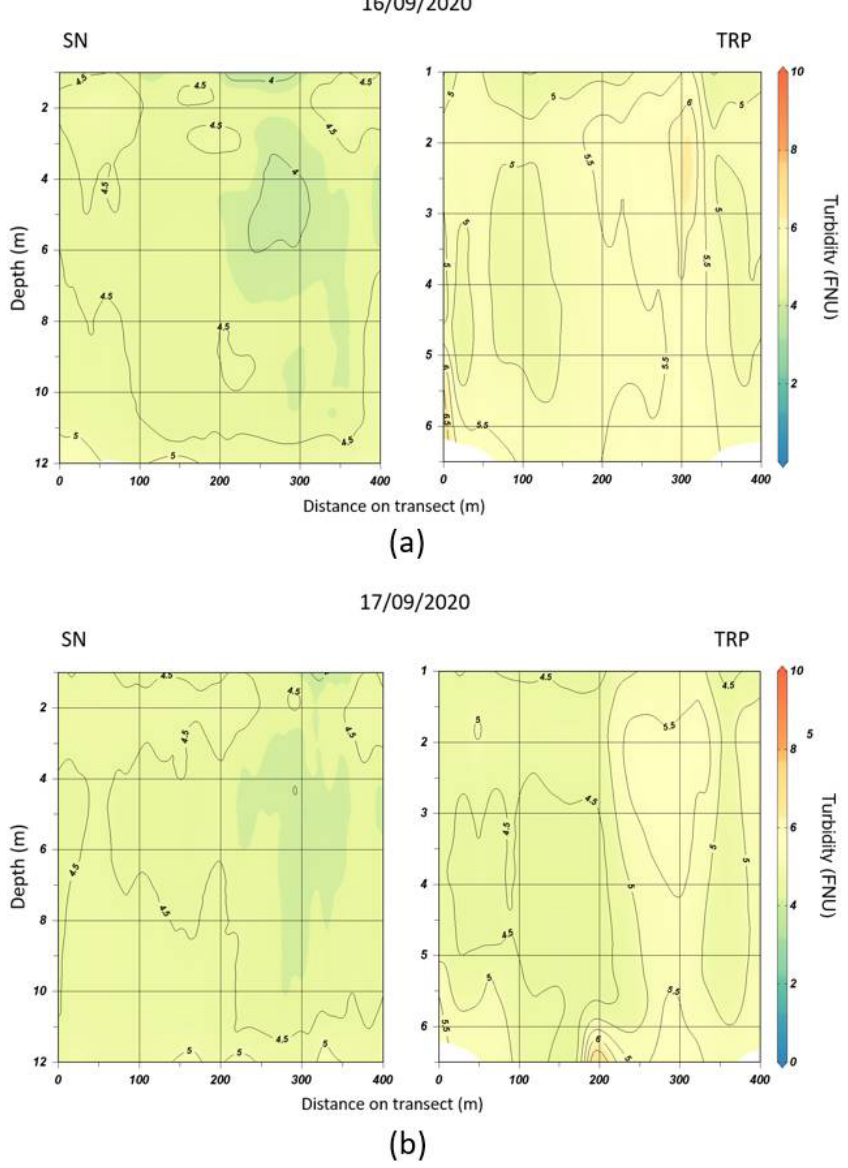
Figure 14. Turbidity values along the transects in sections SN ( left panels) and TRP ( right panels) (panel a ) measurements done on 16 September 2020 (9:40 AM SN transect, 10:00 AM TRP transect) and in (panel b ) 17 September 2020 (10:02 AM SN transect, 10:23 AM TRP transect) September 2020. The direction of all the transects is SW to NE. Plot generated with Ocean Data View software (https://odv.awi.de, 2021 accessed on 12 July